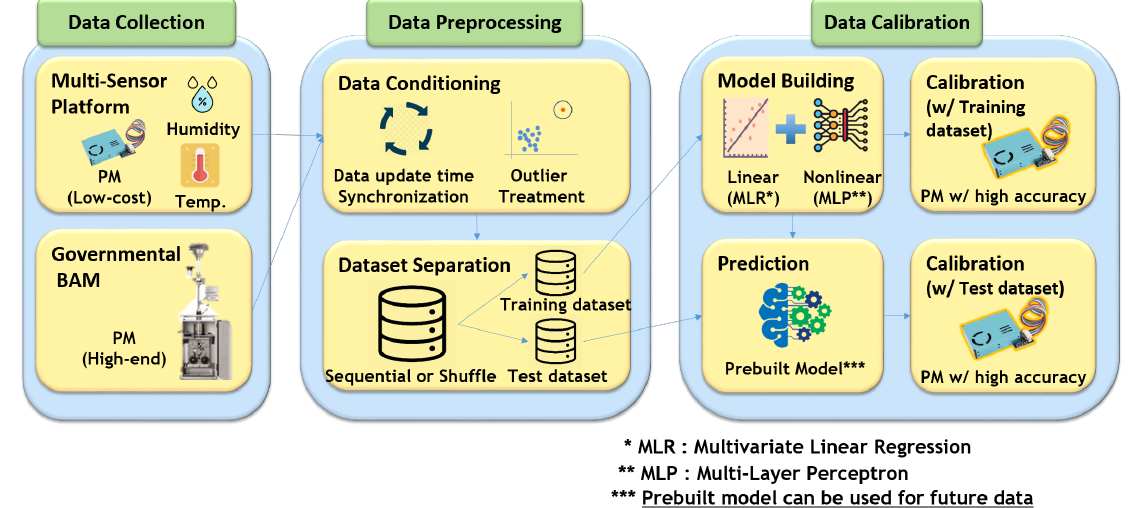
Figure 2. Overall procedures for sensor evaluation and calibration.